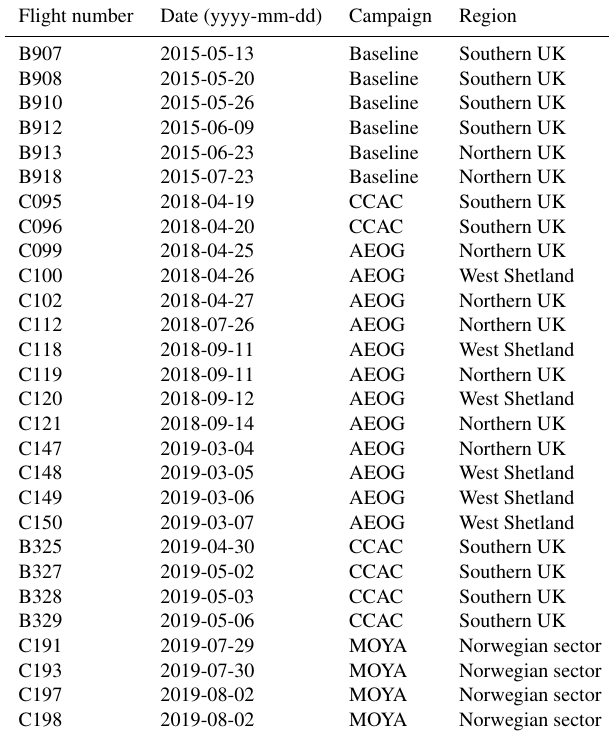
Table A1. Summary of flight data used in this study. MOYA – Methane Observation and Yearly Assessment, CCAC – Climate and Clean Air Coalition, AEOG – Assessing Atmospheric Emissions from the Oil and Gas Industry. Baseline refers to a set of initial flights conducted in 2015 to serve as a comparison in future work. Regions are those defined in Fig. 1a.